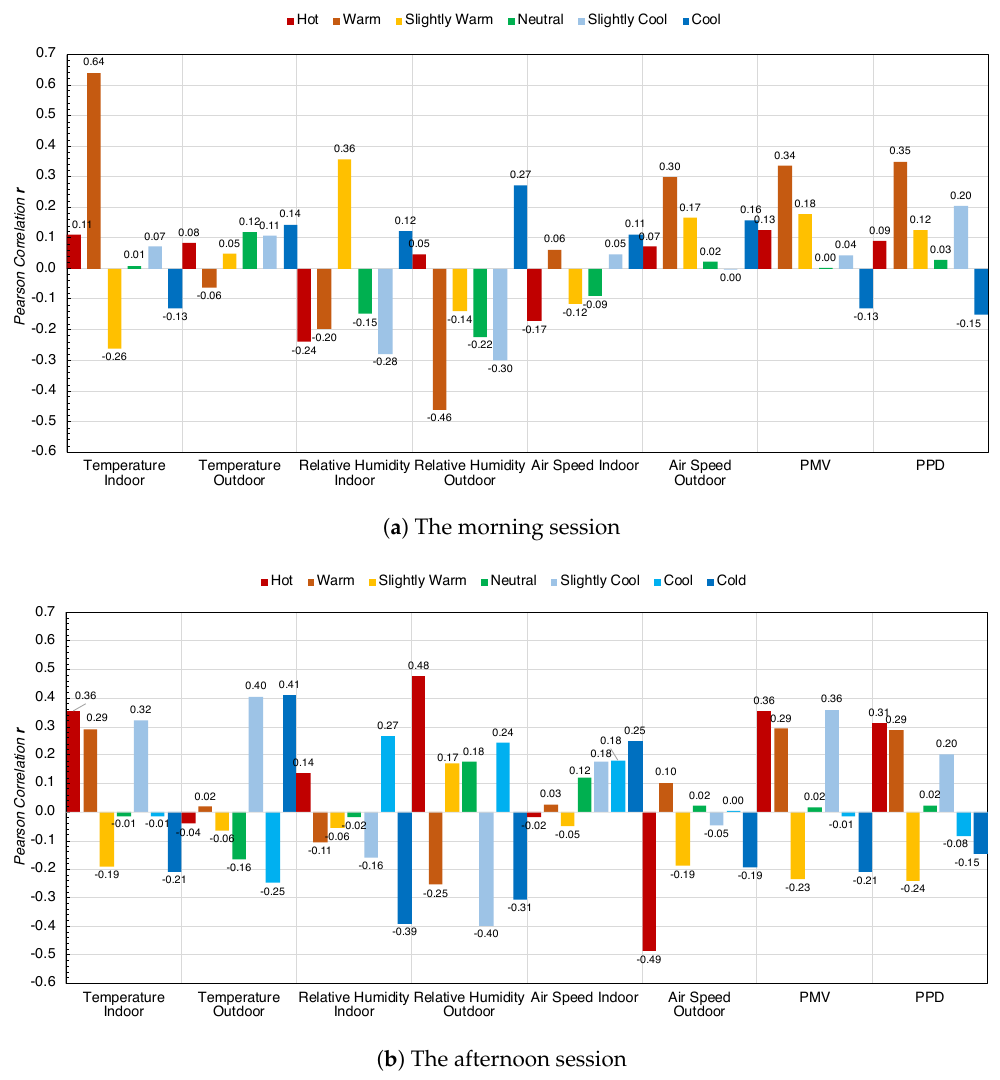
Figure 4. Average Pearson correlation r between the environmental parameters and heart